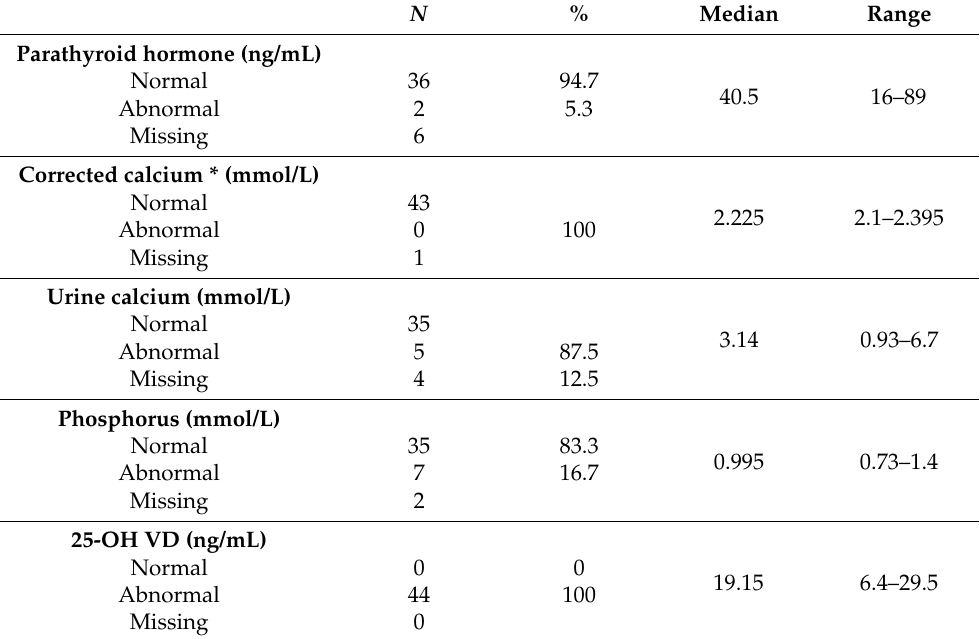
Table 2. Baseline VD and calcium